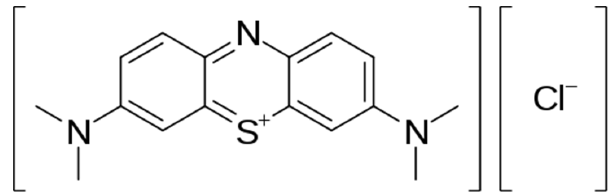
Figure 1. The molecular structure of MB.